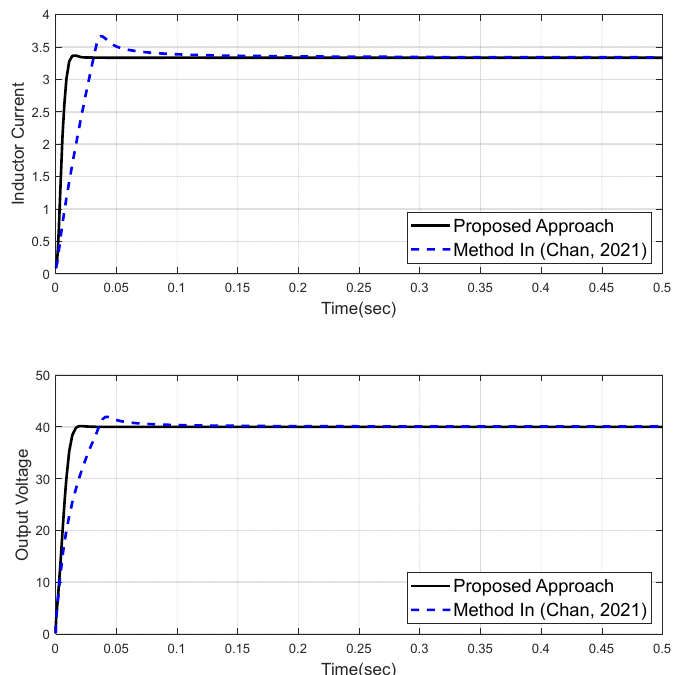
Figure 3. Comparison of the behaviour of the inductor current and output voltage with the results of the method in Ref. [1] .